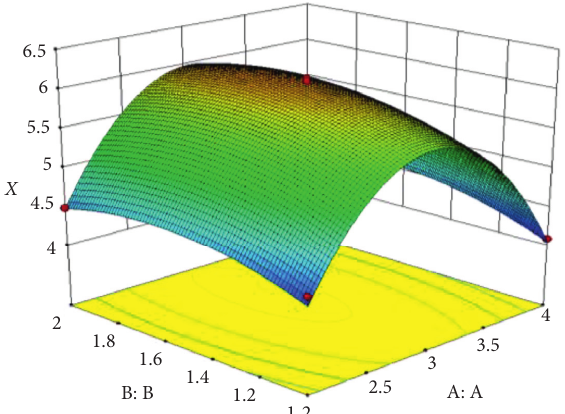
Figure 8: The interaction term AB.